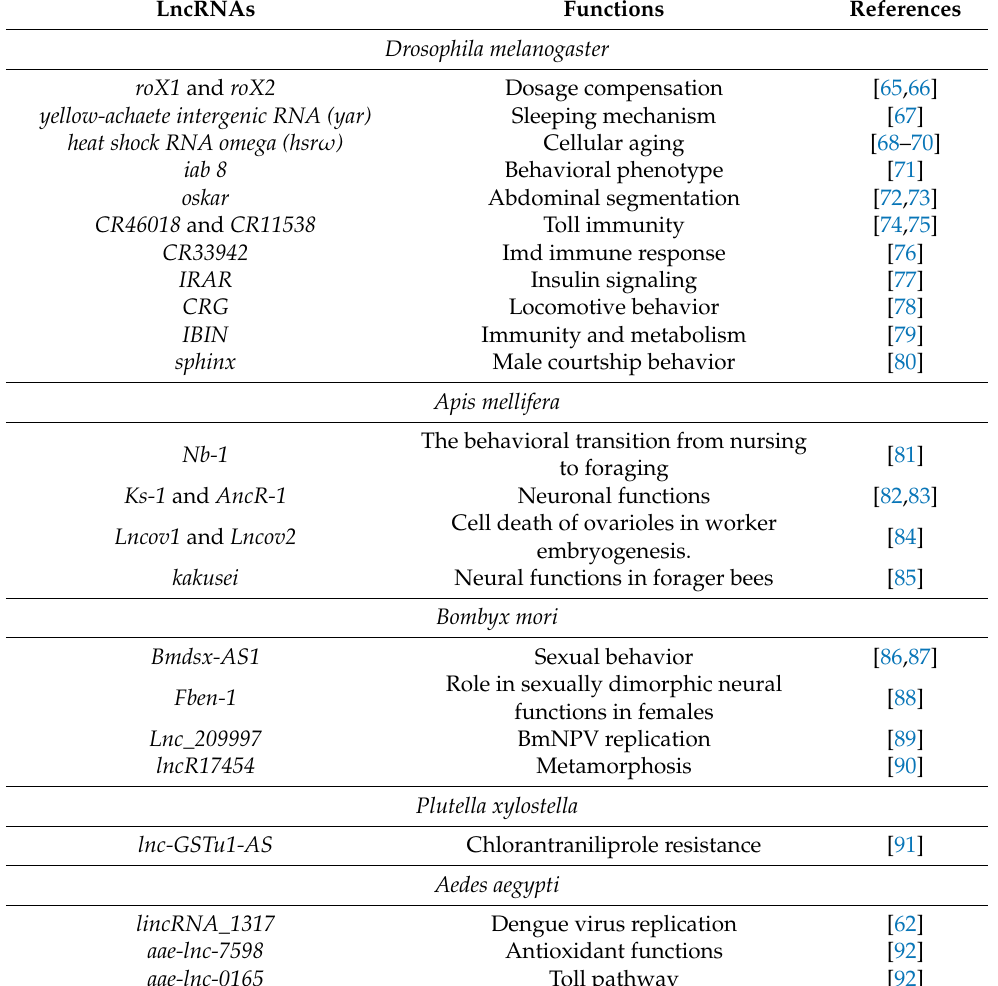
Table 2. List of lncRNAs identified from different